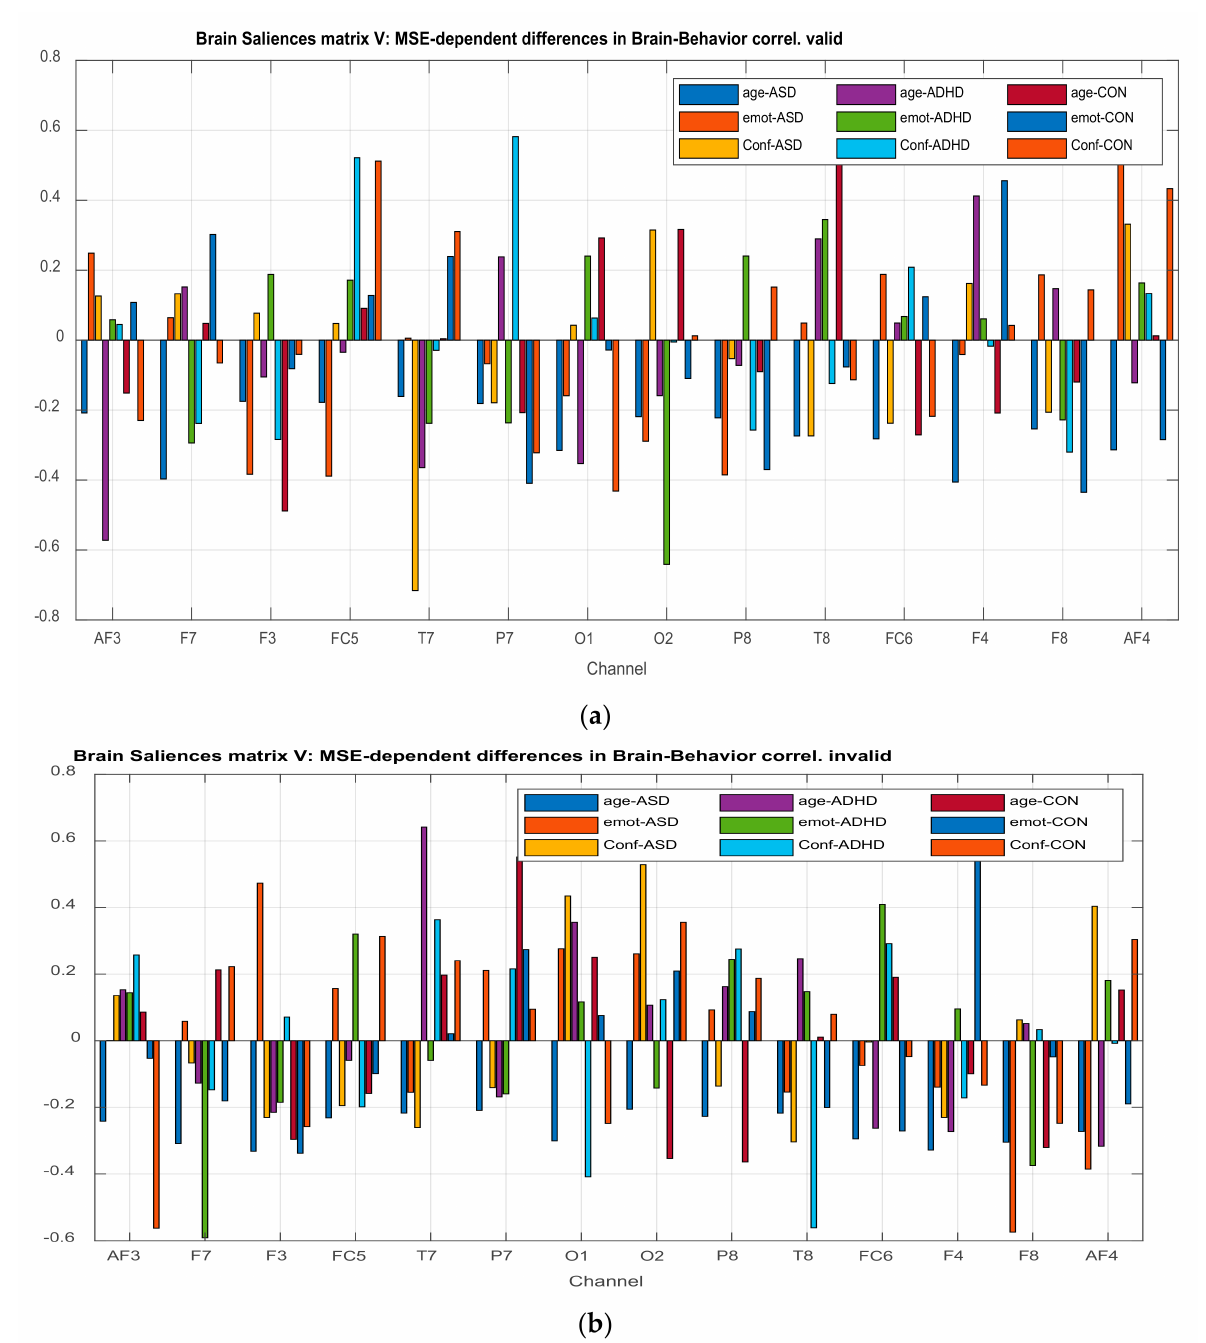
Figure 18. ( a ) Plot of saliences for brain matrix V (right singular vectors) row-wise. Each plotted row corresponds to a channel and depicts how the MSE dependent differences in brain–behavior correlations weigh on that channel, in the case of valid syllogism. ( b ) Plot of saliences for brain matrix V (right singular vectors) row-wise. Each plotted row corresponds to a channel and depicts how the MSE dependent differences in brain–behavior correlations weight on that channel, in the case of invalid